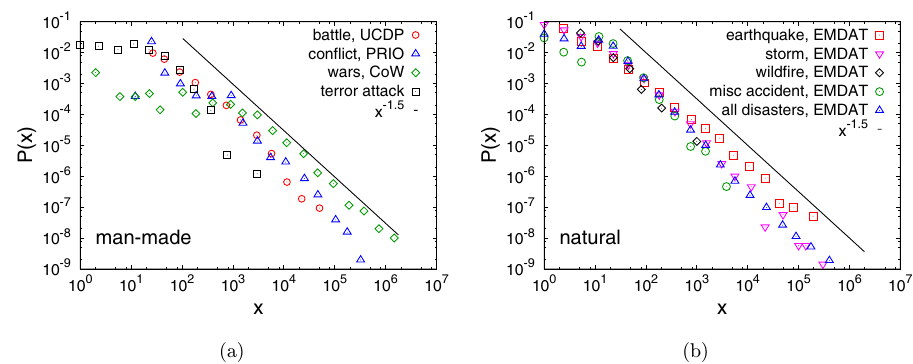
Fig. 3. The probability distributions P ð x Þ of event size x , measured by the number of human deaths in the corresponding event. (a) Man-made events : human deaths from con°icts during 1946 – 2008, according to the PRIO database 43 (using lowest estimates), dead according to the CoW database 37 during 1816 – 2007, dead in terror attack 46 during 1910 till July 2016, and battle deaths according to UCDP database 45 during 1989 – 2014. Except the terrorist attack data, all these distributions seem to have a power law tail with similar exponents. The straight line is a guide to the exponent value 1 : 5 for comparison. (b) Natural disasters : human death from earthquakes, storms, wild¯res, miscellaneous accidents, as well as all natural disasters listed in the EMDAT database 47 during 1900 – 2013. The precise values of the estimated expo- nents are given in Table